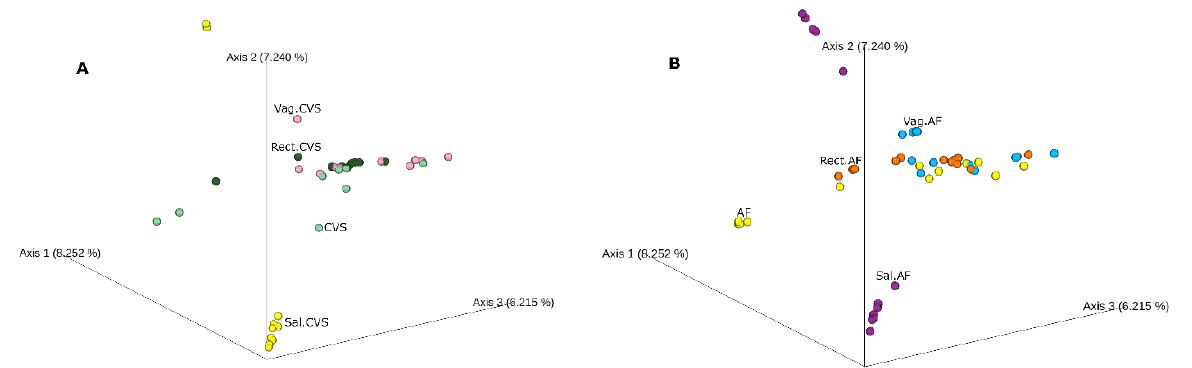
Figure 2. The beta diversity. Principal coordinate analysis (PcoA) based on Bray–Curtis dissimilarity matrix of bacterial communities in the analyzed groups. ( A ) CVS positive for bacterial DNA (light green) and matched vaginal (pink), rectal (dark green), and saliva (yellow) samples. ( B ) AF samples (yellow) and matched vaginal (light blue), rectal (orange), and saliva (purple) samples. Not all the analyzed samples are visible; hiding samples in an ordination can be misleading.